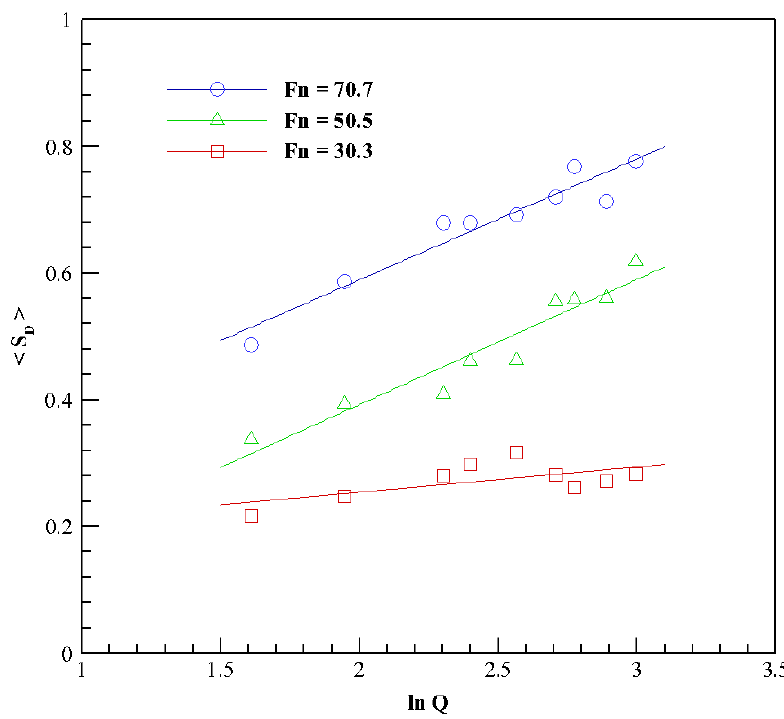
Figure 14. The linear variation of the time-averaged spatial density, < S D > , with the logarithm of the air injection rate, ln ( Q ) , at different Froude numbers, Fn . R 2 values for Fn equal to 70.7,50.5 and 30.3 were equal to 0.92,0.92 and 0.4, respectively.